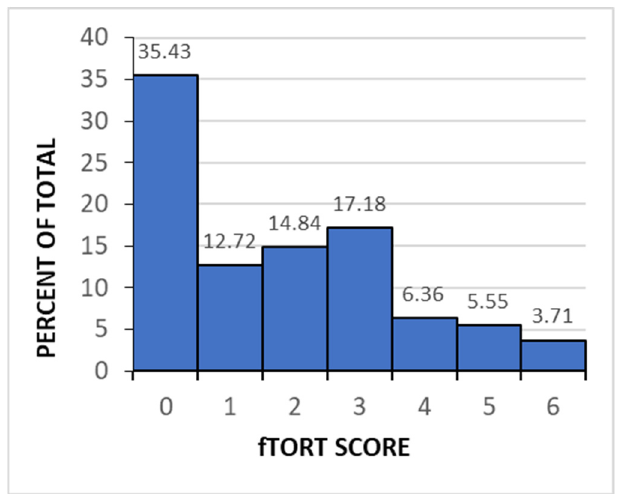
Figure 5. Distribution is expected for total scores of 0–6 in the fTORT if an insensate responder selects an object at random from the 42 items presented visually.